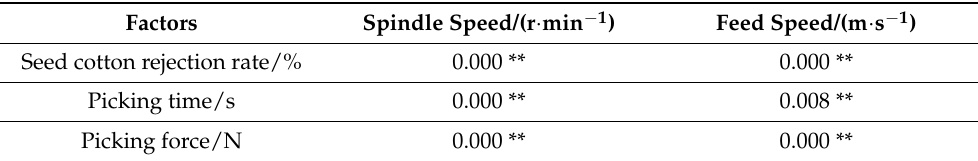
Table 4. Analysis of variance of test results.